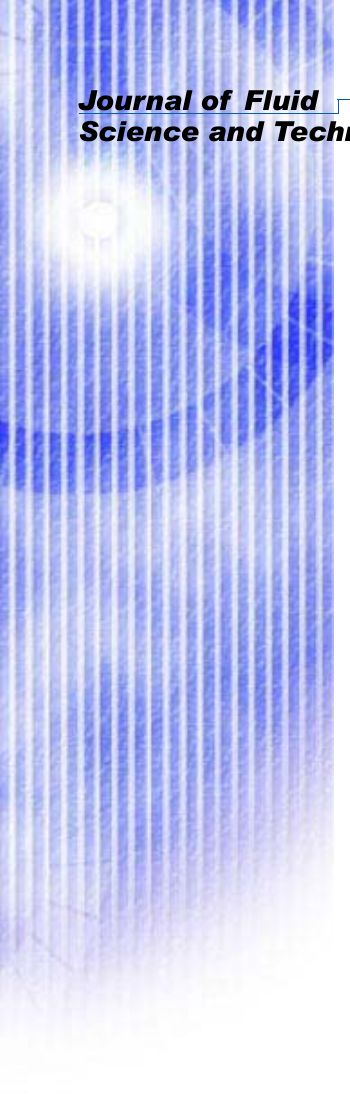
Figure 6 shows the average film thickness in the conditions for droplet entrainment, non-dimensionalized as Eq. (2), and indicated with regard to the liquid film Reynolds number Re defined by Eq. (3). f